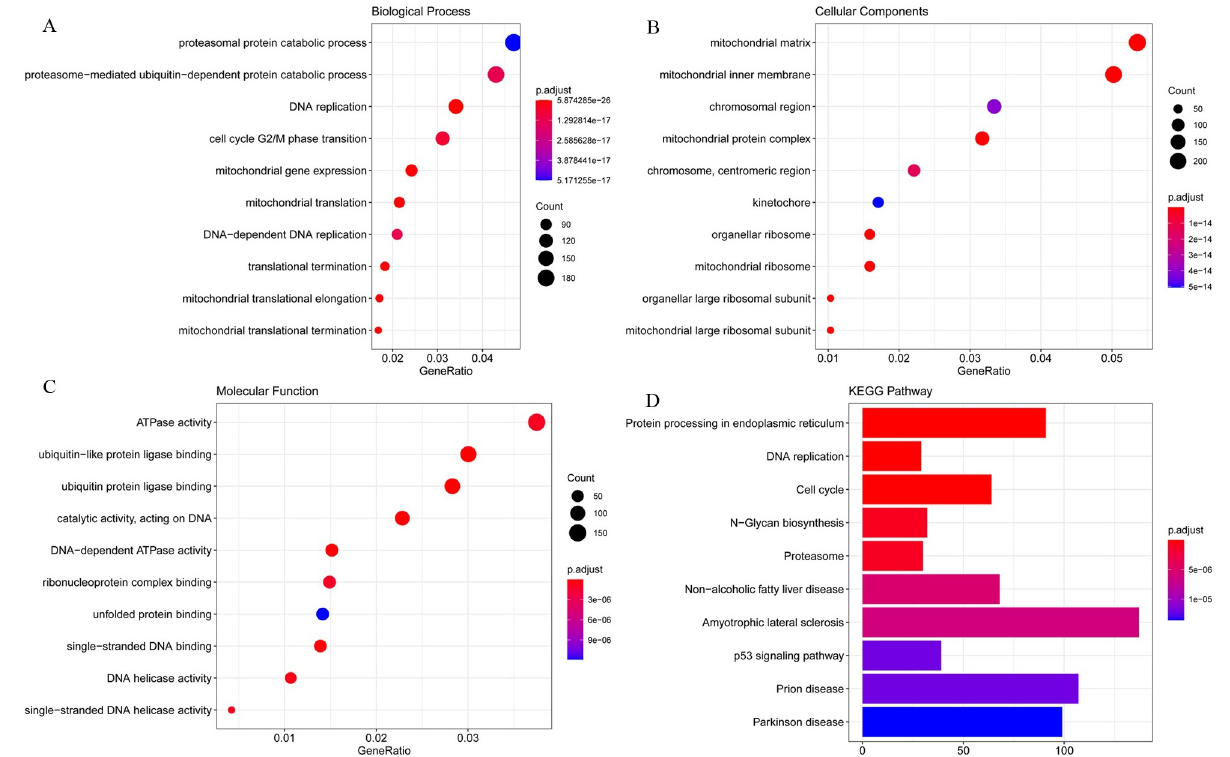
Fig 5. The GO enrichment analysis and KEGG pathways analysis of GSE51808. Abbreviation: GO, Gene Ontology; KEGG, Kyoto Encyclopedia of Genes and Genomes; DEGs, differentially expressed genes.